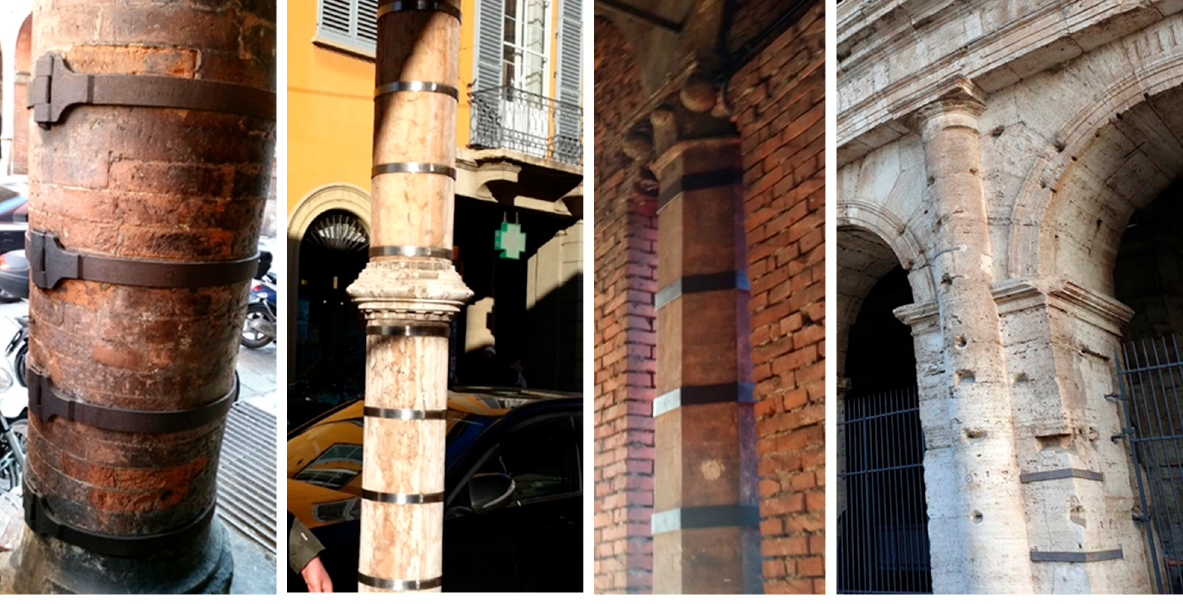
Figure 15. Brick and stone columns confined with discontinuous wrap configuration, Bologna, Italy.